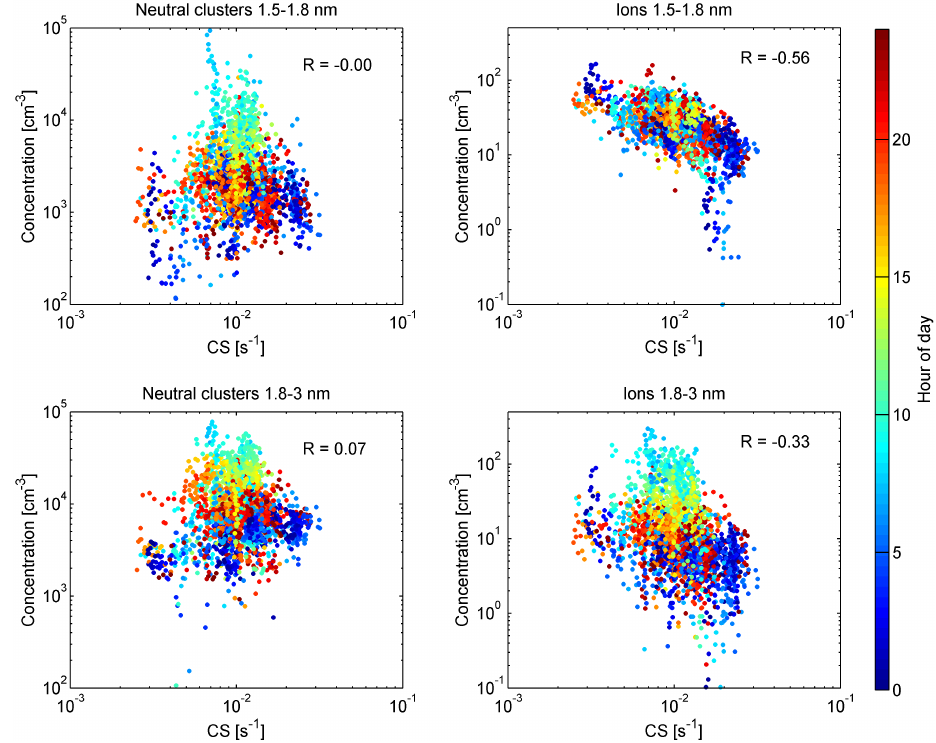
Figure 10. The correlation between the neutral and charged 1.5–1.8 and 1.8–3.0nm clusters and condensation sink (CS). The color bar shows the hour of the day. The correlation coefficients ( R ) are presented in the